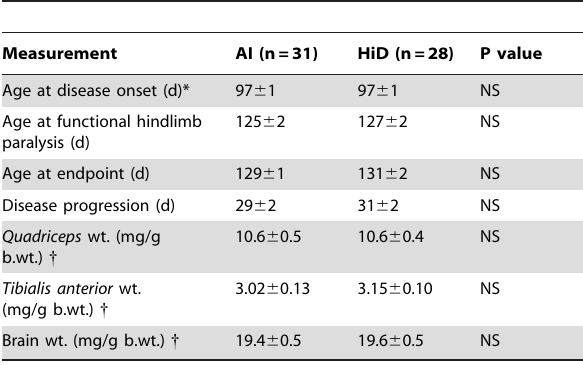
Table 5. Disease outcomes and tissue weights between the diet groups in G93A mice.